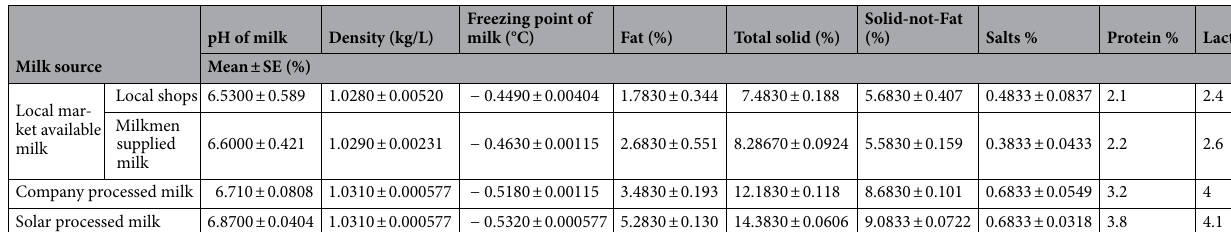
Solid-not-Fat (%) Salts % Protein % Lactose %